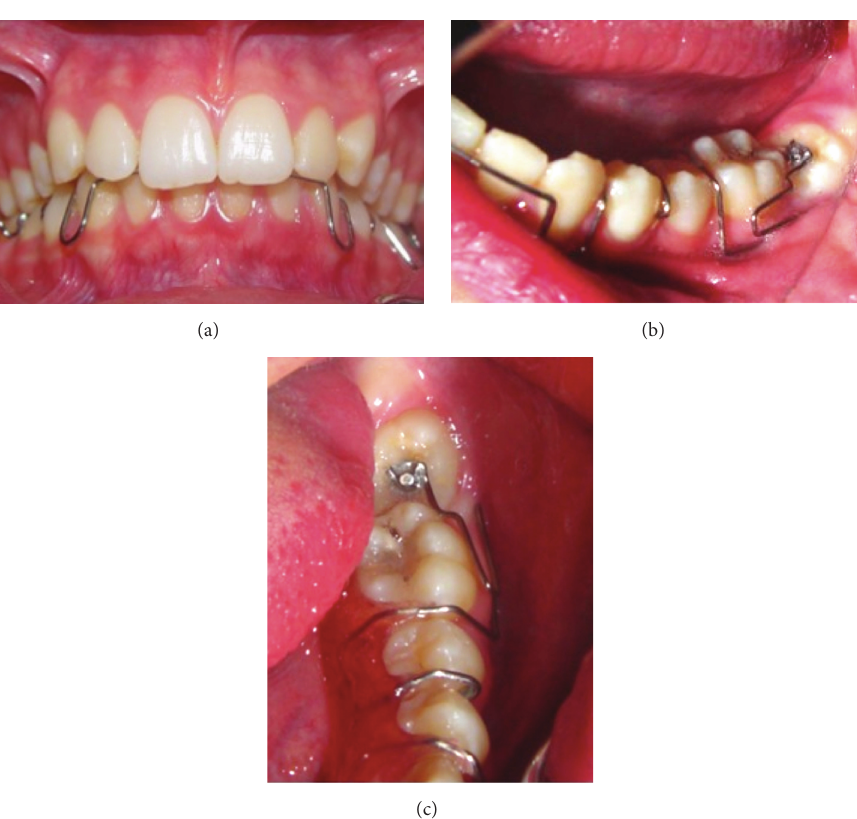
Figure 3: Clinical view after applying appliance: (a) frontal view, (b) left view, and (c) occlusal